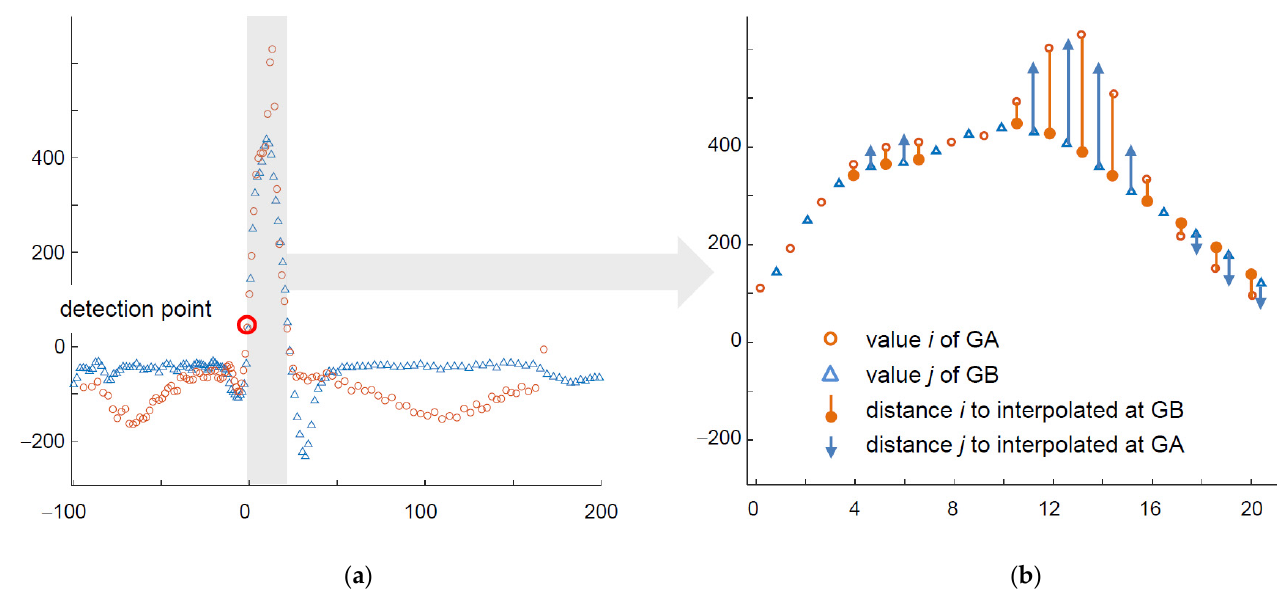
Figure 2. Principle of the similarity score calculation for non-uniform patterns ( a ) whole heartbeat, ( b ) magnified QRS region.